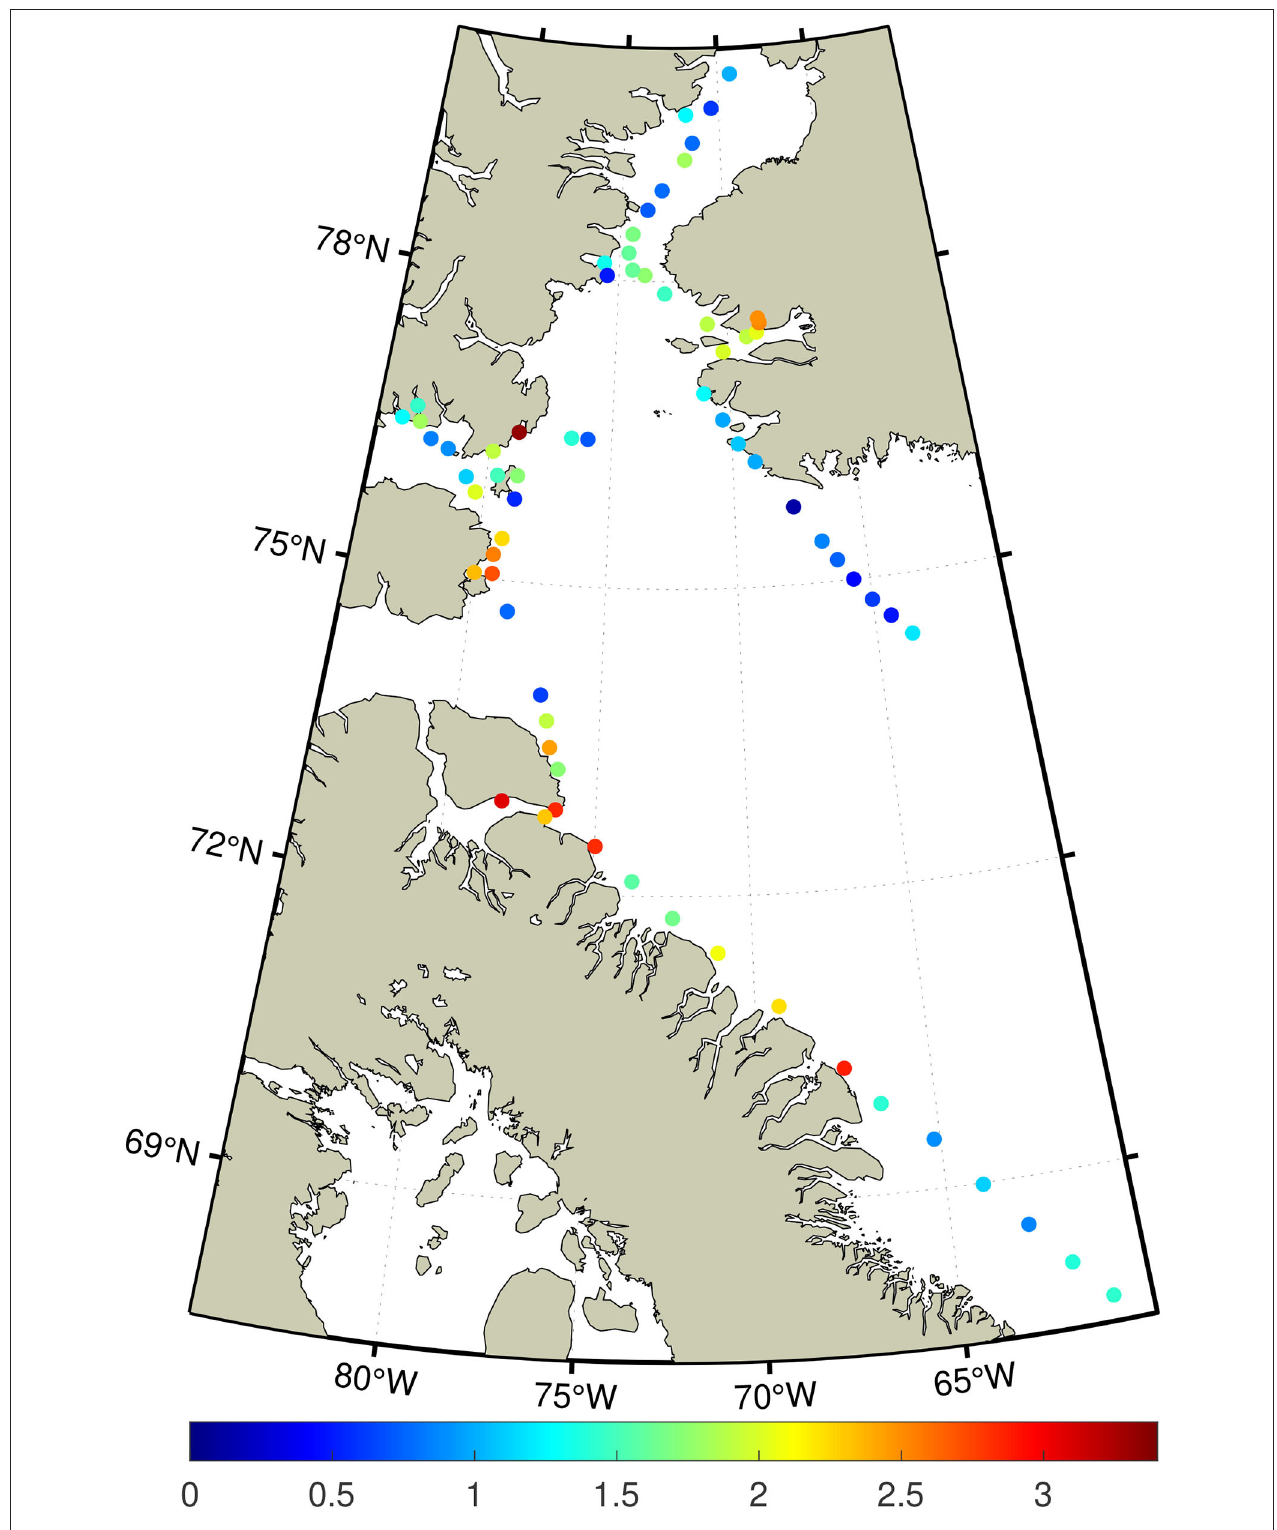
FIGURE 2 | The freshwater content (FWC; units of meters) of the upper 40 m in northern Baffin Bay is indicated by color-coded circles. The FWC ranged from 0.12 to 3.33 m during the 2017 survey.